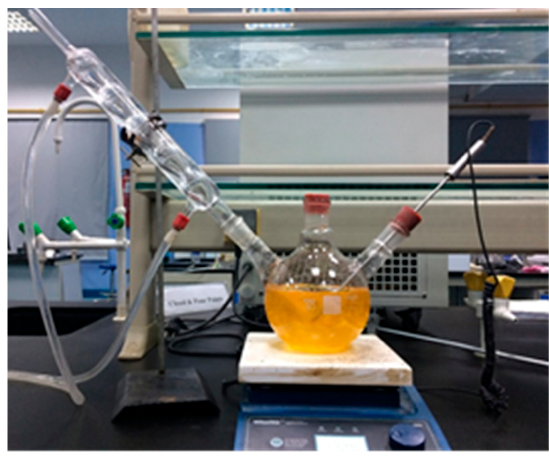
Figure 1. Experimental setup.